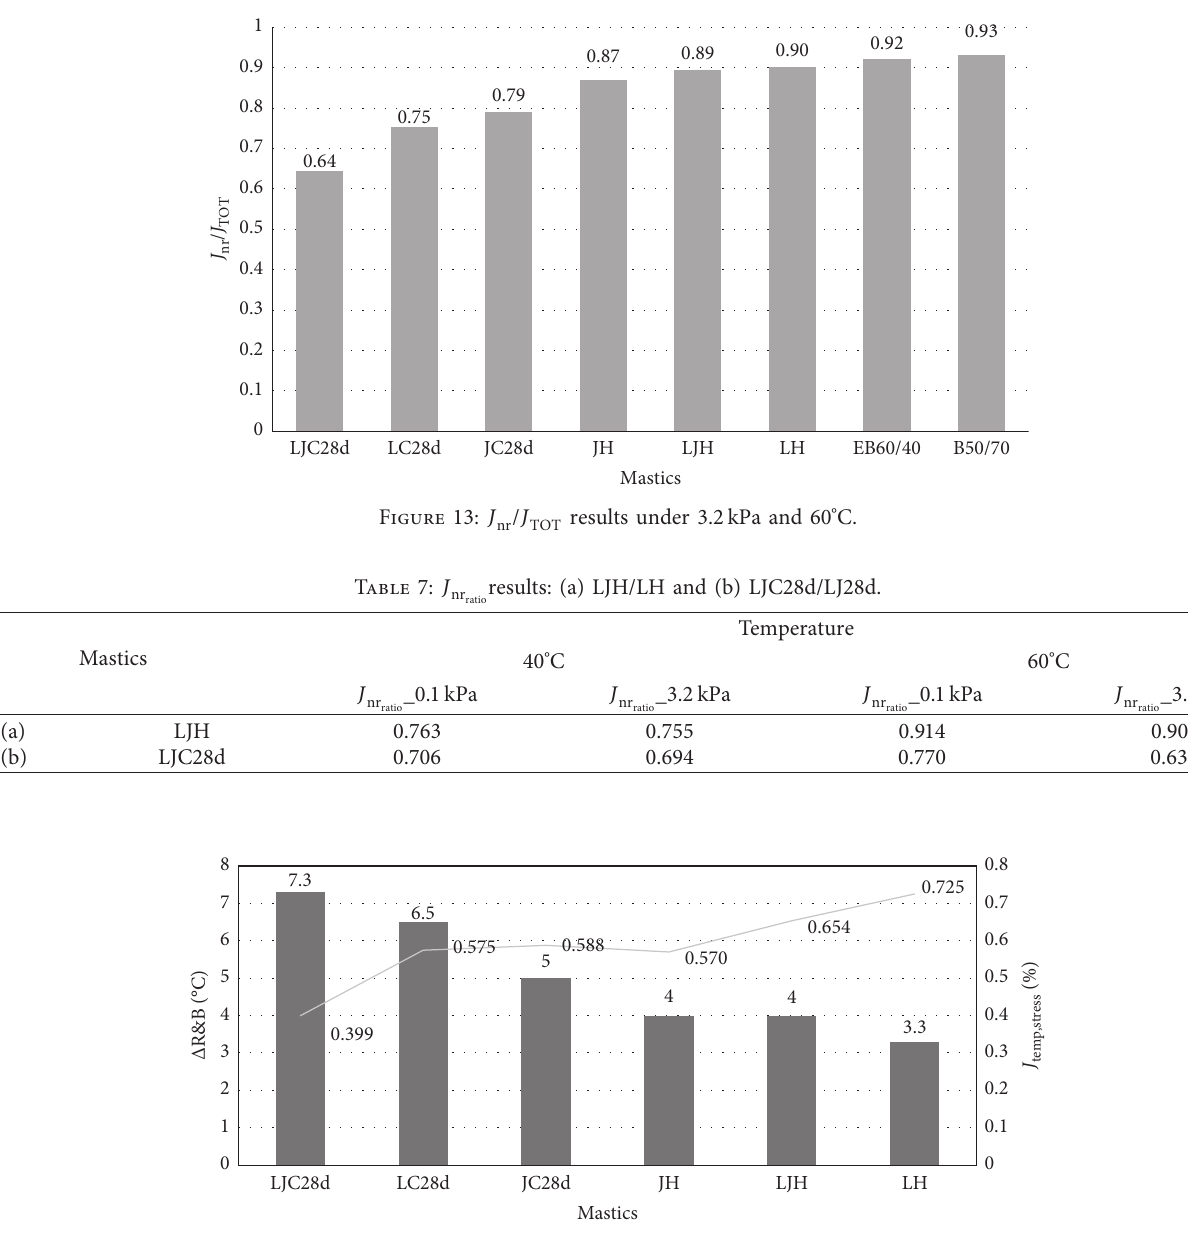
Figure 14: Delta ring and ball results compared with J